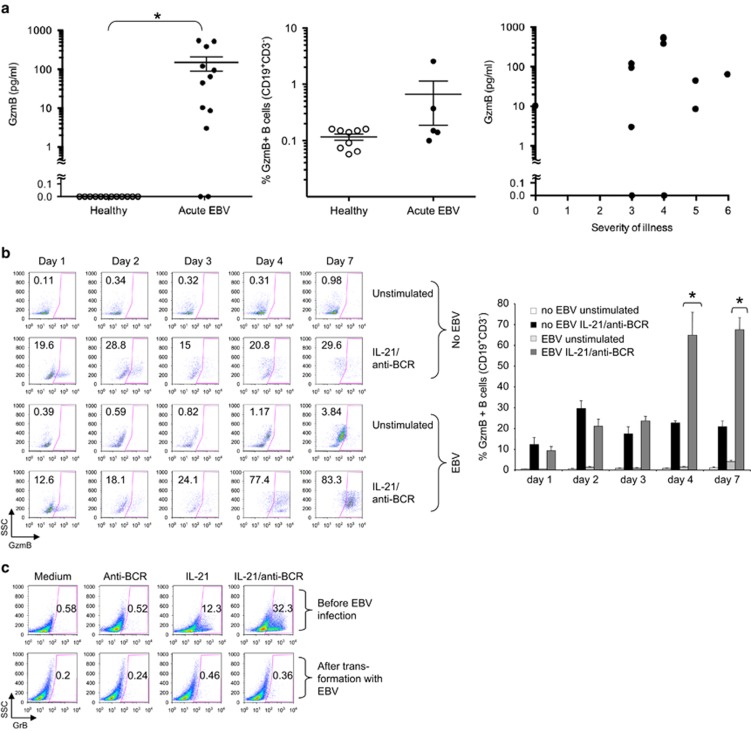
Patients with freshly diagnosed IM show elevated serum levels of granzyme B, likely due to large secretion from B cells during acute, but not chronic infection with EBV. After obtaining informed consent, peripheral blood and serum was taken from healthy donors or patients with recently diagnosed IM, as determined by detection of anti-VCA-IgM, or age-matched EBV+ healthy controls (n=12 each group). (a) Left panel shows results of serum levels of GzmB in each donor, as determined by cytometric bead array (BD Biosciences, San Jose, CA, USA). Horizontal lines represent mean levels in each group±s.e.m. *Indicates two-sided P-value <0.0001 for the difference between patients and healthy individuals by Mann–Whitney U test. Middle panel shows percentages of GzmB+ B cells in patients and healthy controls as determined by intracellular flow cytometry (mean±s.e.m.). Cells were harvested following 4 h incubation with Brefeldin A (1 μg ml−1), fixed, permeabilized, and GzmB expression was assessed using a PE-labelled GzmB antibody (1:400, Sanquin, Amsterdam, The Netherlands). Cell-surface markers were analysed using anti-CD3 and anti-CD19 (BD Biosciences). Right panel shows the severity of illness index in each patient compared with GzmB levels. (b, c) PBMC from healthy donors were isolated and either infected with the B95.8 strain of EBV or left untreated. After infection, cells were plated in 48-well plates at 1 × 106 cells per ml and stimulated for 16 h with or without human recombinant IL-21 (50 ng ml−1, Invitrogen, Carlsbad, CA, USA) and 6.5 μg ml−1 anti-BCR (affinity purified rabbit F(ab')2 against human IgA+IgG+IgM (H+L); Jackson ImmunoResearch Laboratories, West Grove, PA, USA) on the time points indicated. Next, cells were harvested on indicated time points after infection, and GzmB expression was assessed by intracellular flow cytometry. (b) Left panel: dot plots show percentages of GzmB+ CD19+ CD3− B cells. Right panel: bar graphs depict summarized results of five independent experiments. Error bars show±s.e.m., *Indicates P<0.01 by Student's t-test. (c) Dot plots show GzmB+ B cells from freshly isolated B cells from a healthy volunteer (purity >99%, upper panel, negative selection, Miltenyi Biotech, Bergisch Gladbach, Germany) or after full in vitro transformation with the B95.8 strain of EBV (4–5 weeks after infection). B cells were stimulated for 16 h with either IL-21 or anti-BCR or both. Successful EBV transformation was determined by observation of distinct morphological feature changes by microscopy and by expression of EBNA-2 protein in B cells by western immunoblot (not shown).